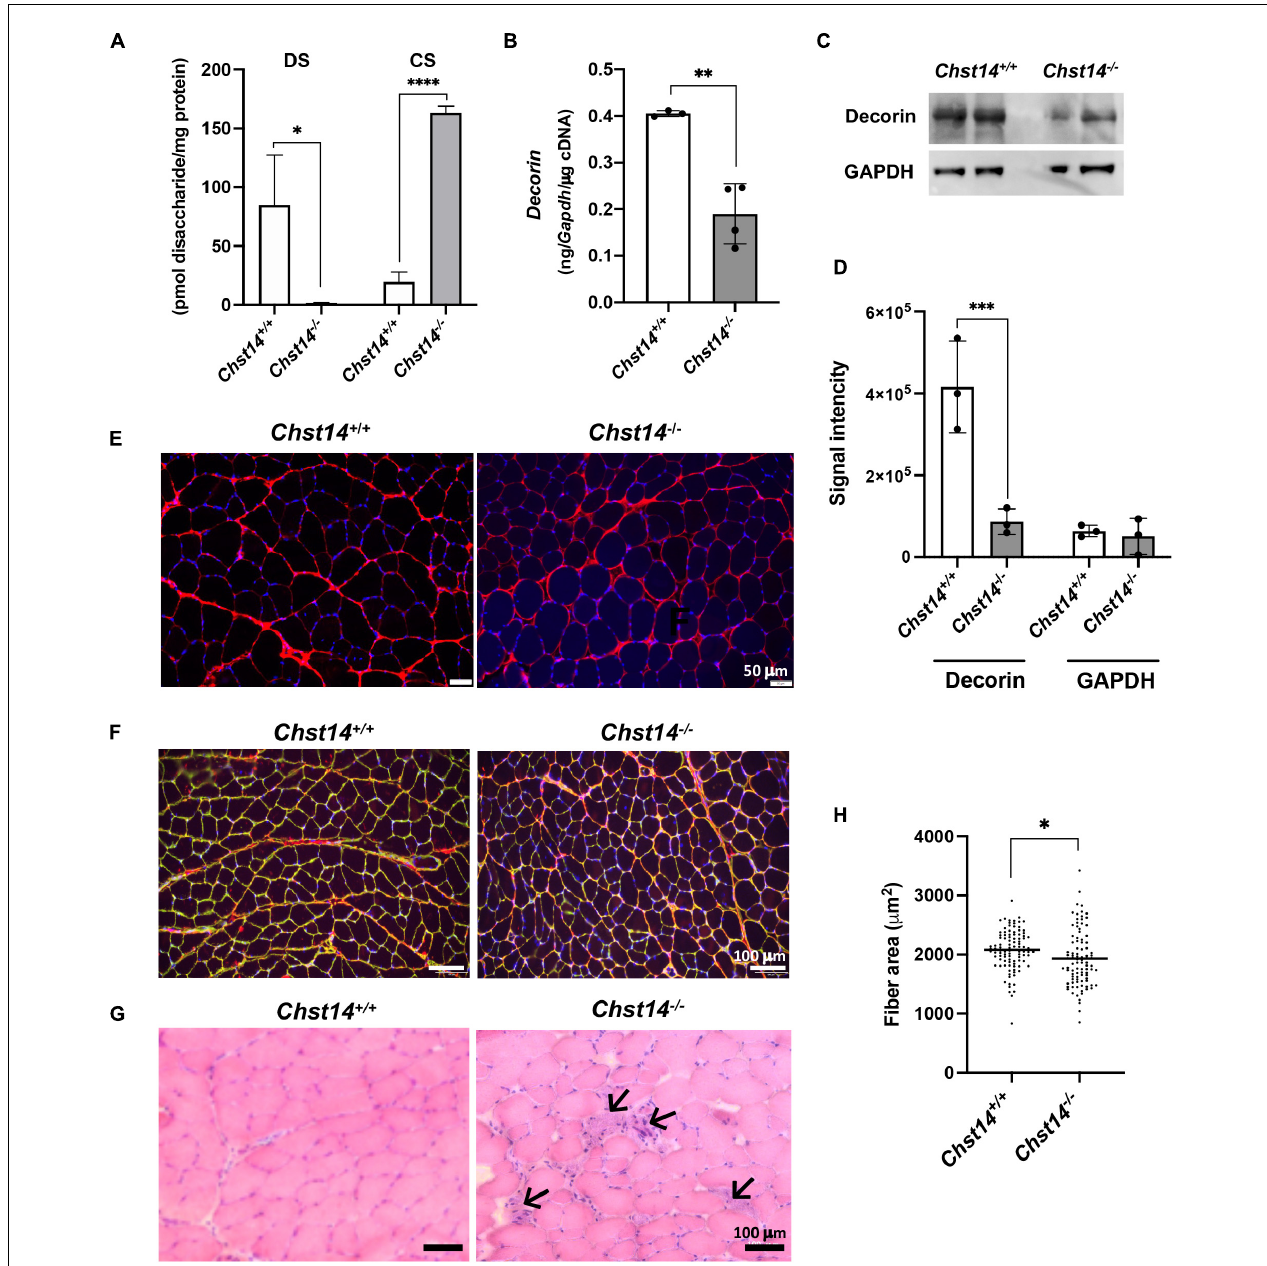
FIGURE 1 | Decorin expression and localization in dermatan sulfate (DS) deficient muscle. (A) Total amounts of chondroitin sulfate (CS) and DS disaccharides derived from the tibialis anterior (TA) muscle of Chst14 + / + and Chst14 − / − mice, analyzed by anion-exchange HPLC after enzymatic digestion. (B) Decorin mRNA in the TA muscle from Chst14 + / + ( n = 3) and Chst14 − / − ( n = 4) mice was quantified by reverse transcription polymerase chain reaction (RT-PCR). Quantitative data were normalized using the glyceraldehyde 3-phosphate dehydrogenase ( Gapdh ) signal. (C) The protein level of decorin in the TA muscle were analyzed by western blotting using anti-decorin antibody and anti-glyceraldehyde 3-phosphate dehydrogenase (GAPDH) antibodies. (D) Signal intensity quantified using blotting band images using Image Quant TL software. (E) Immunofluorescence staining of TA muscle from Chst14 + / + and Chst14 − / − mice was performed using anti-decorin antibody (red signals). Nuclear staining was detected using 4,6-diamidino-2-phenylindole (blue signals). Bars, 50 µ m. (F) Dual staining of the TA muscle from Chst14 + / + and Chst14 − / − mice for the detection of decorin (red signals) and laminin (green signals) with nuclear staining (blue signals). Bars, 100 µ m. (G) Hematoxylin and eosin (H&E) staining of the TA muscle from Chst14 + / + and Chst14 − / − mice. Arrows show the nuclear accumulation and spread of muscle fiber stroma. Bars, 100 µ m. (H) Muscle fiber areas ( µ m 2 ) measured from the TA muscle of Chst14 + / + and Chst14 − / − mice using H&E staining. Each fiber area is indicated by a dot, and the average fiber area is described as a bar for each muscle. In total, 1931 fibers are represented in the dot plot. Median values are indicated by red bars. Statistical differences between Chst14 + / + and Chst14 − / − (* P < 0.05, ** P < 0.01. *** P < 0.001, and **** P < 0.0001), t -test. All data were analyzed using the TA muscle of 1-year-old sex-matched Chst14 + / + ( n = 3) and Chst14 − / − ( n = 3) mice.